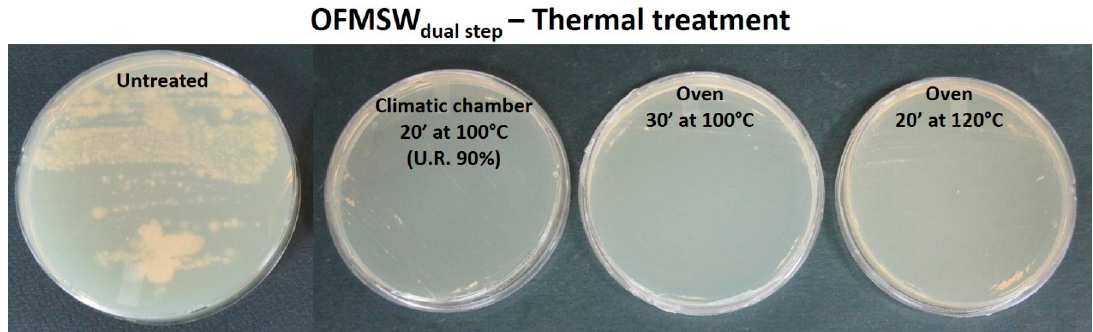
Figure 4. Bacterial growth on OFMSW samples subjected to thermal treatment.